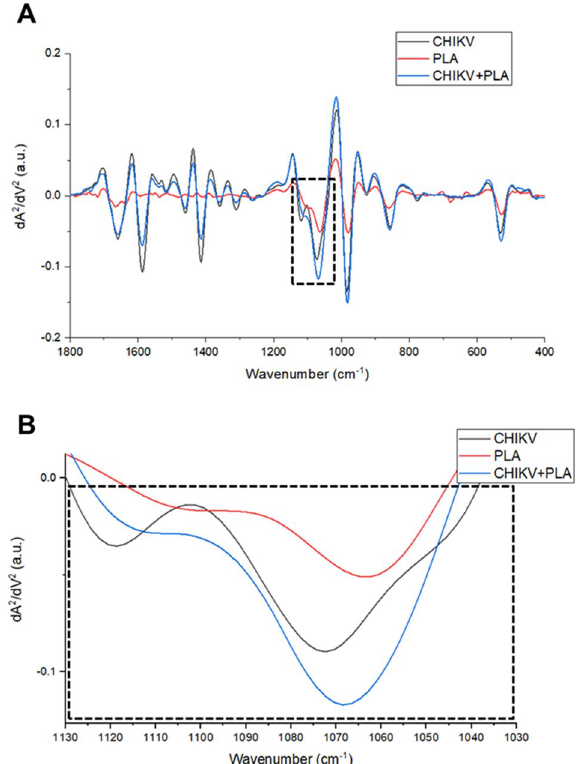
Figure 8. Infrared spectroscopy Spectral analysis indicates interactions between CHIKV virion and PLA CB . ( A ) Representative infrared average spectrum of second derivative analysis from PLA2 CB (red line), CHIKV virion (black line), and PLA2 CB plus CHIKV virion (blue line) employing an Fourrier Transform Infrared (FTIR) methodology. ( B ) Second derivative analysis, which the value heights indicate the intensity of each functional group. All images were generated using GraphPad Prism 8 and GIMP 2.10.20 (www. gimp. org).